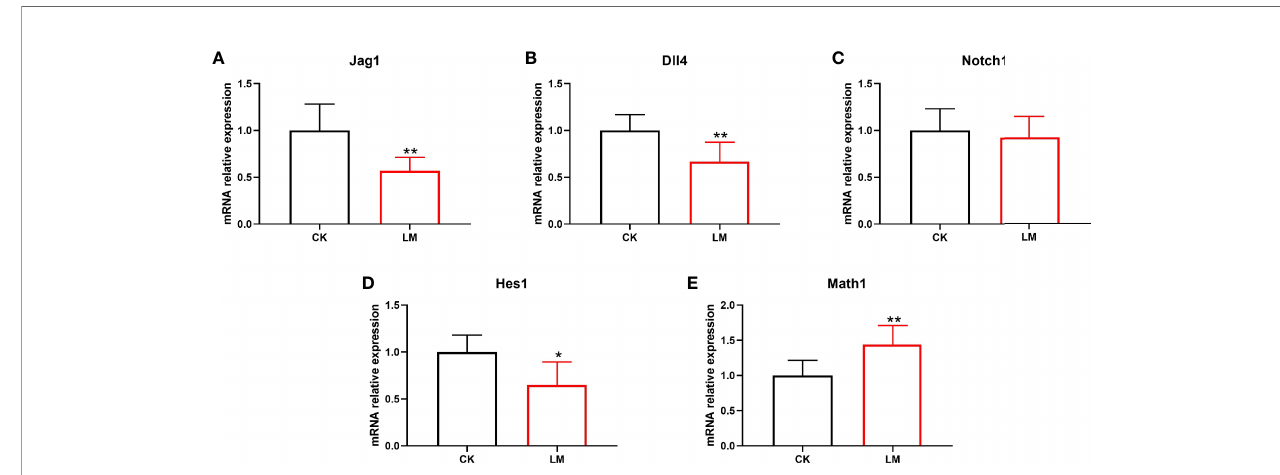
FIGURE 3 | The in fl uence of L. monocytogenes on the Notch pathway in mice. CK, control, orally challenged with PBS; LM, L. monocytogenes -infected group. (A-E) The expression of Jag1 , Dll4 , Notch1 , Hes1 and Math1 genes were determined by quantitative RT-PCR and normalized by the expression of GAPDH . Data is presented as mean ± SD. * P < 0.05, ** P < 0.01. Data combined from at least three independent experiments unless otherwise